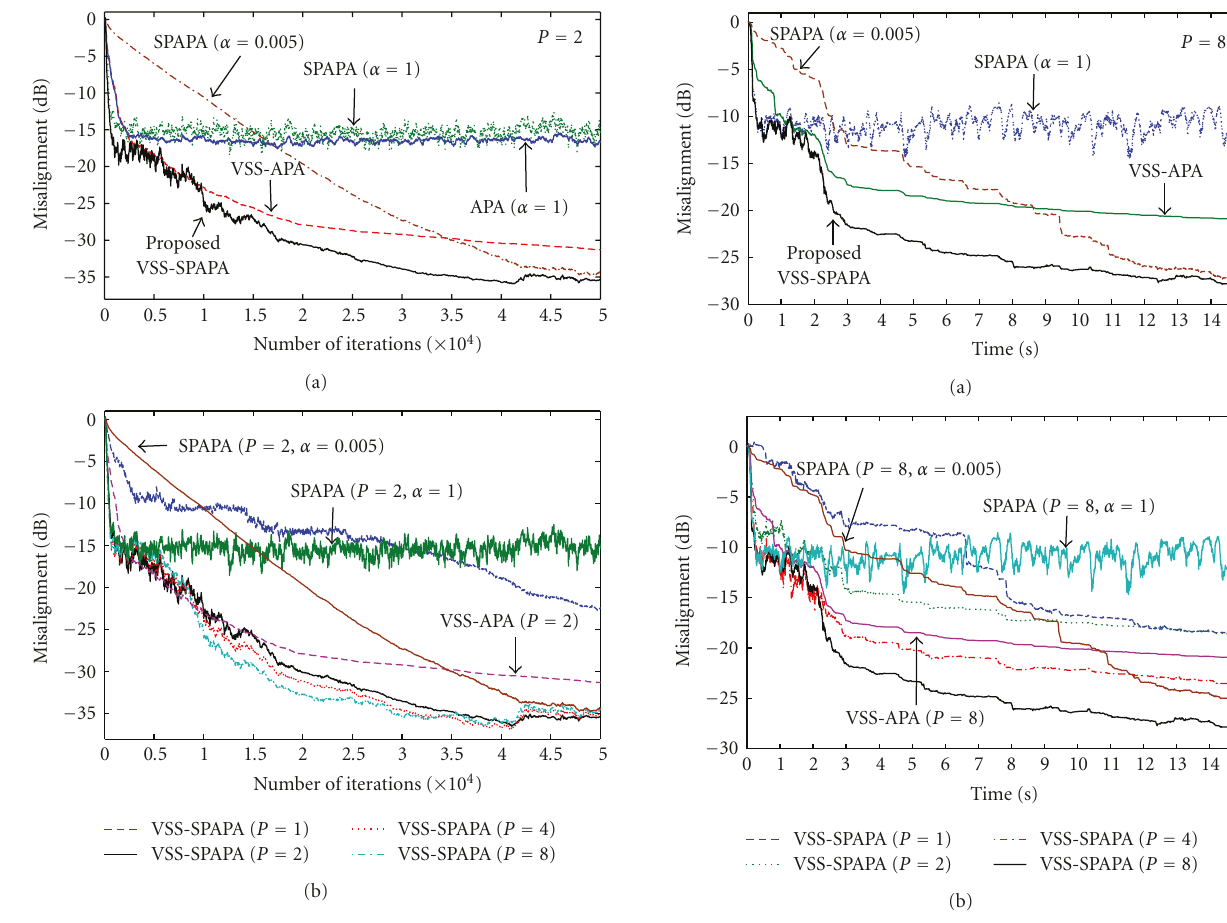
Figure 4: Misalignment of the algorithms with speech signal. (a) P = 8. (b) Comparison with di ff erent projection order, P = 1, 2, 4, 8. SPAPA and VSS-APA are also